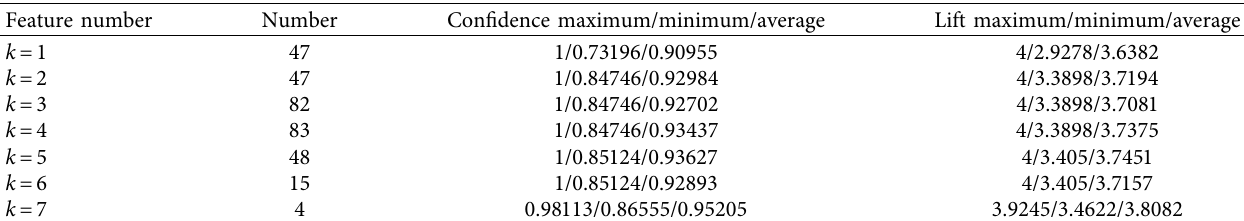
Table 14: Fault diagnosis rule extraction results based on the confidence-improint framework.